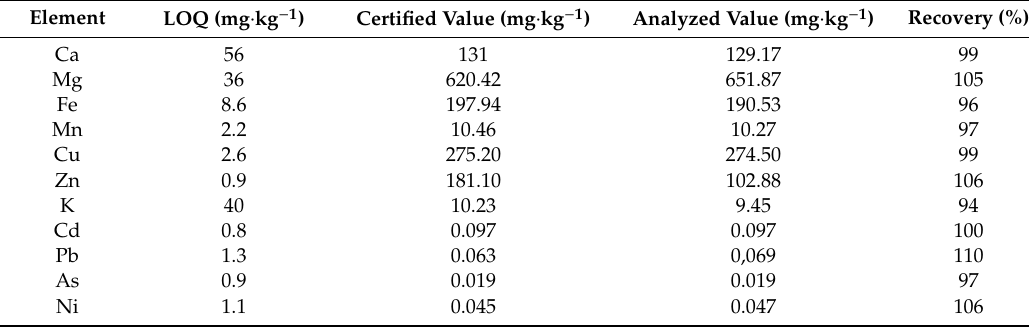
Table 1. Results of the analysis of certified reference materials and proficiency